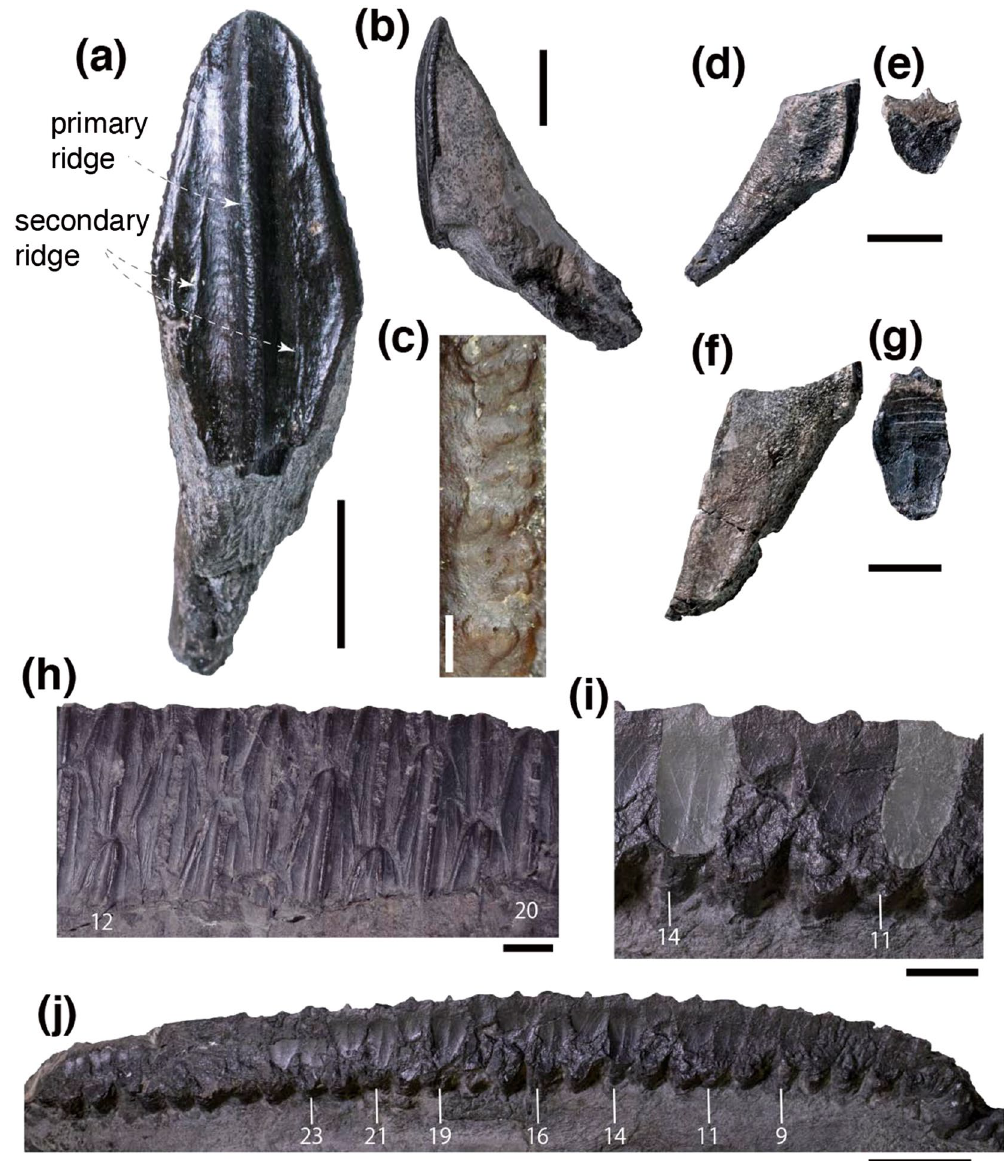
Figure 4. An isolated dentary tooth of Yamatosaurus izanagii gen. et sp. nov. from left side in lingual ( a ) and mesial ( b ) views and its denticles ( c ). Isolated dentary teeth of Yamatosaurus izanagii gen. et sp. nov. from left side in distal ( d , f ) and occlusal ( e , g ) views. Dentary teeth of Yamatosaurus izanagii gen. et sp. nov. in place on the right dentary in lingual ( h ) and occlusal ( i ) view. Numbers in ( h ), ( i ), and ( j ) are tooth positions. Occlusal surfaces of the eleventh and fourteenth teeth are highlighted in light gray in ( i ). Scales for ( a ), ( b ), and ( d ) to ( i ) are 1 cm. Scales for ( c ) and ( j ) are 0.5 mm and 3 cm,